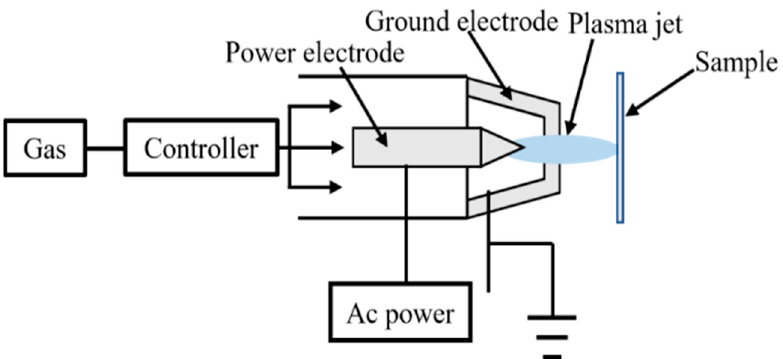
Figure 3. Schematic diagram of atmospheric plasma jet.